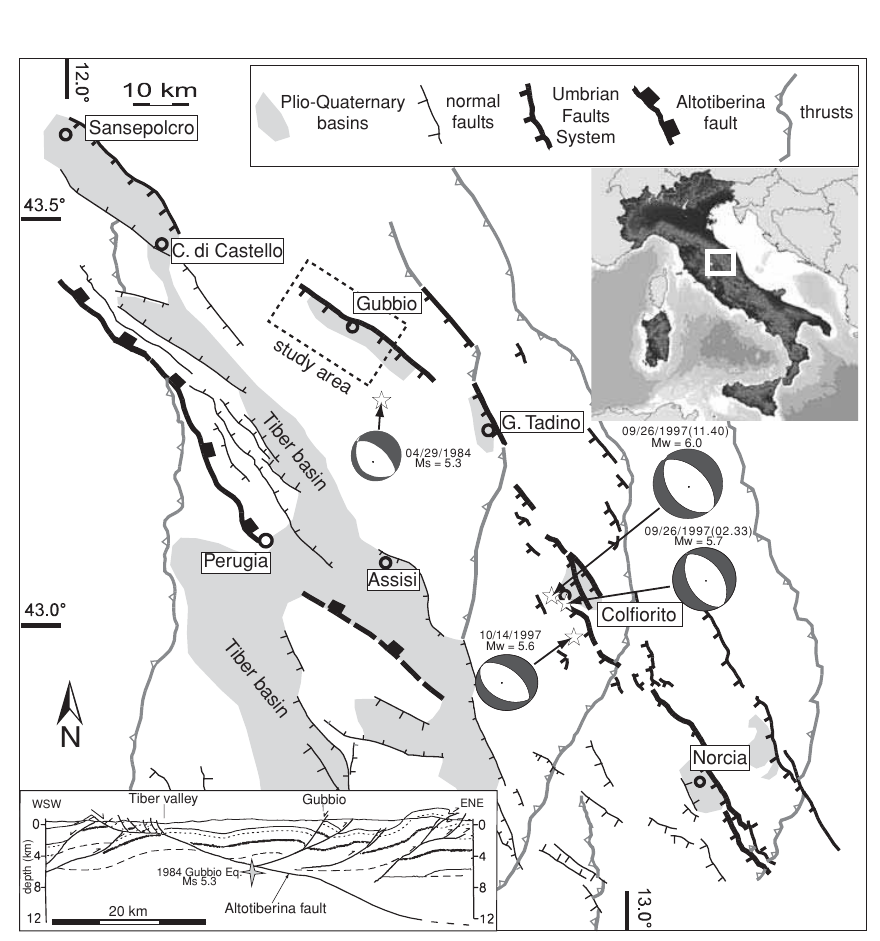
Fig. 1. Structural sketch of the Umbria-Marche domain (from Barchi et al. , 2001, modified) showing the alignment of the intramountain basins along the Umbrian Fault System ( sensu Barchi, 2002), which coincides with the main seismo- genic zone of Central Apennines defined by Valensise and Pantosti (2001a). Focal mechanisms and magnitudes are for the 1997, Colfiorito sequence from Ekström et al. (1998) and for the 1984 Gubbio earthquake from Dziewonski et al. (1985) and ISC (2001). The lower left inset includes a schematic regional geological section integrated with the interpre- tation of seismic profiles and showing also the 1984 Gubbio earthquake mainshock location (after Boncio et al. , 1998,